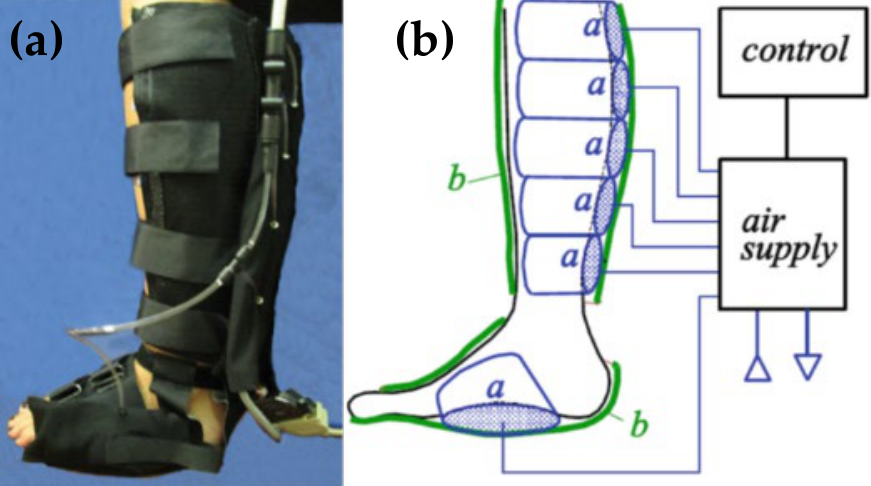
Figure 12. A picture ( a ) and a sketch ( b ) of the six-chamber IPC device [67]. The textile air-pockets are marked with the letter a , the shells with the letter b .